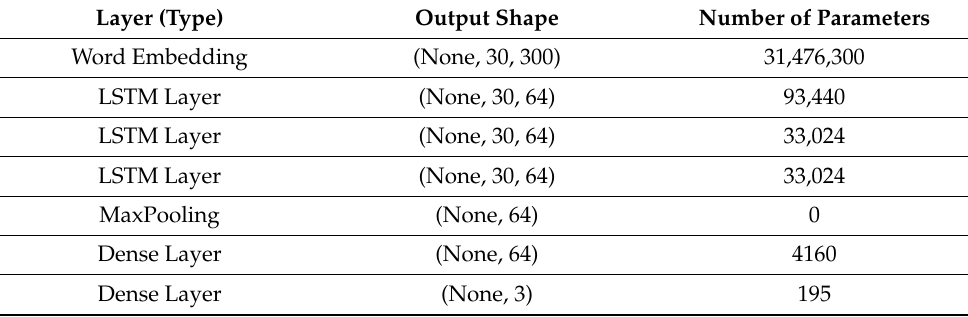
Table 6. Triple-layer LSTM